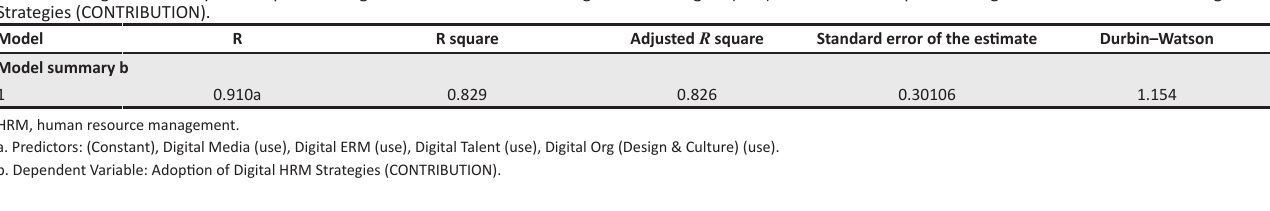
TABLE 5b: Regression analysis: Adoption of Digital Human Resource Management Strategies (USE) factors and Adoption of Digital Human Resource Management Strategies (CONTRIBUTION). Model